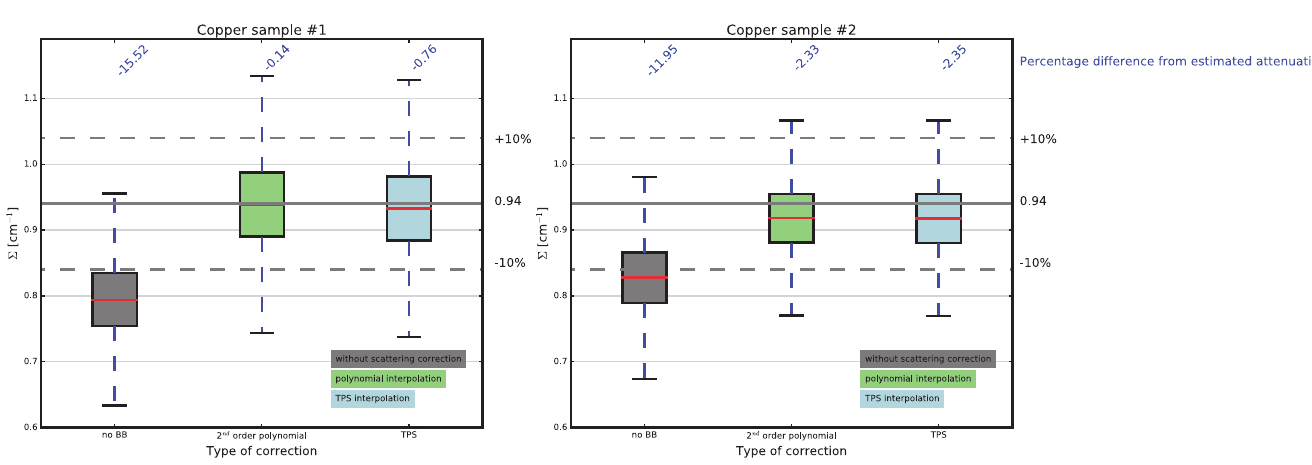
Fig 8. Effect of the interpolation scheme on the computed attenuation coefficients for the copper samples.